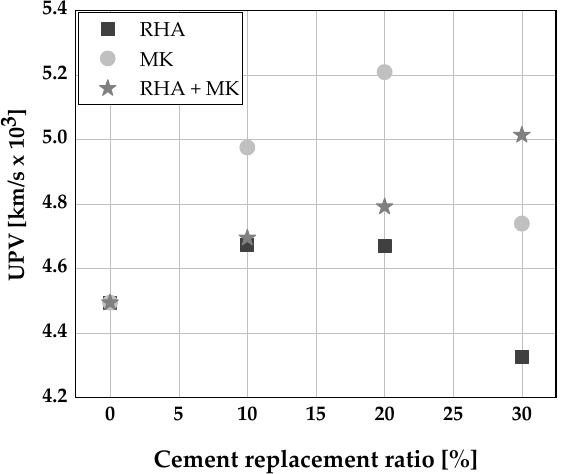
Figure 6. Ultrasonic pulse velocity of SCC [30].